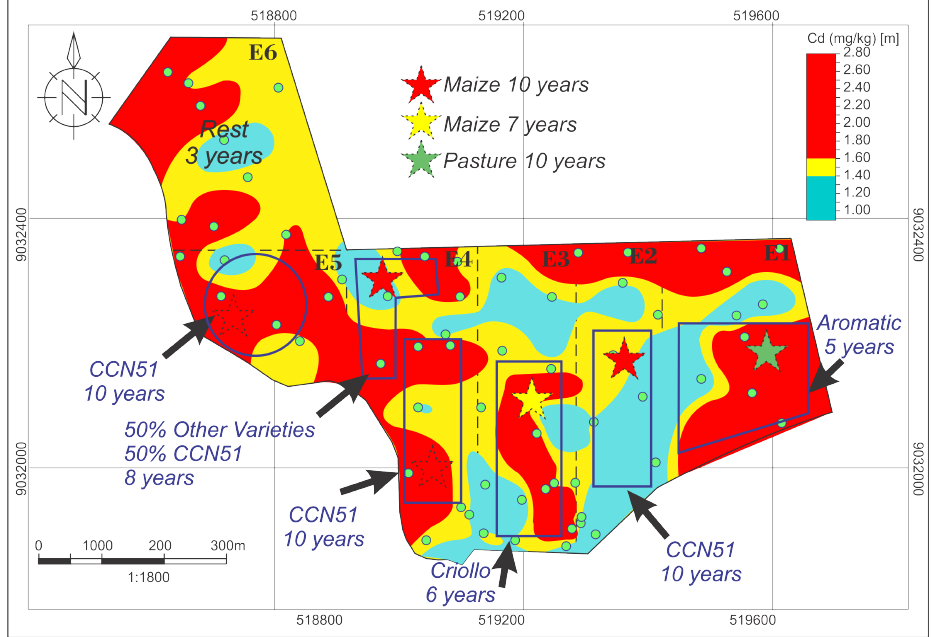
Figure 3. Age of plants and Intensity of land use.